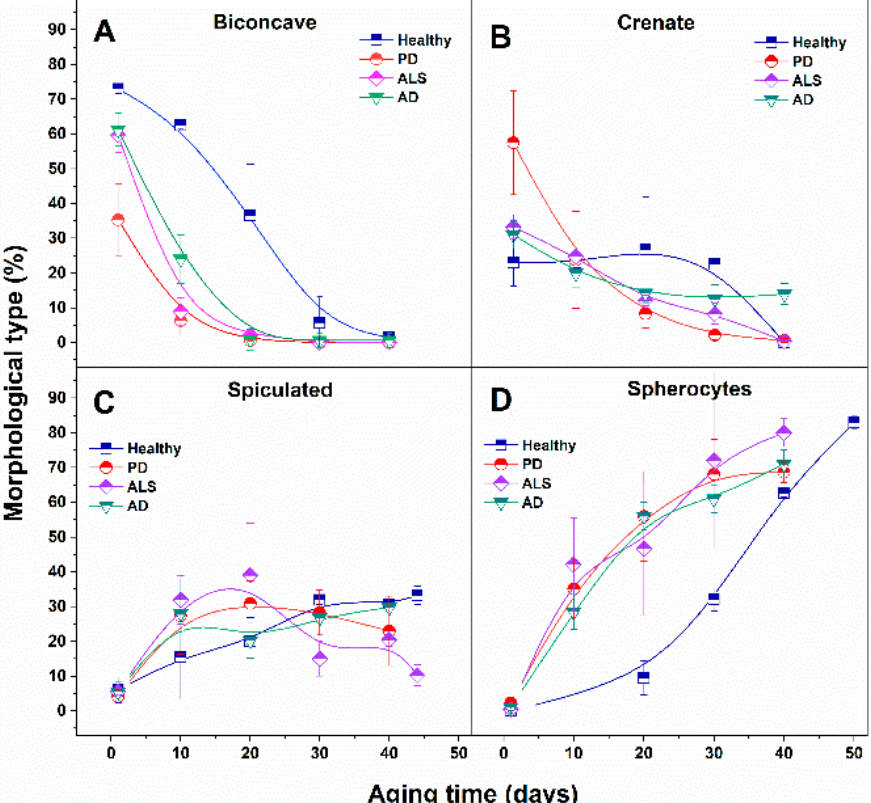
Figure 3. Comparison of the relative contribution (in percentage) of biconcave ( A ), crenate ( B ), speculated ( C ) and spherocytic ( D ) morphological types to healthy, PD, ALS and AD RBCs along the aging time.